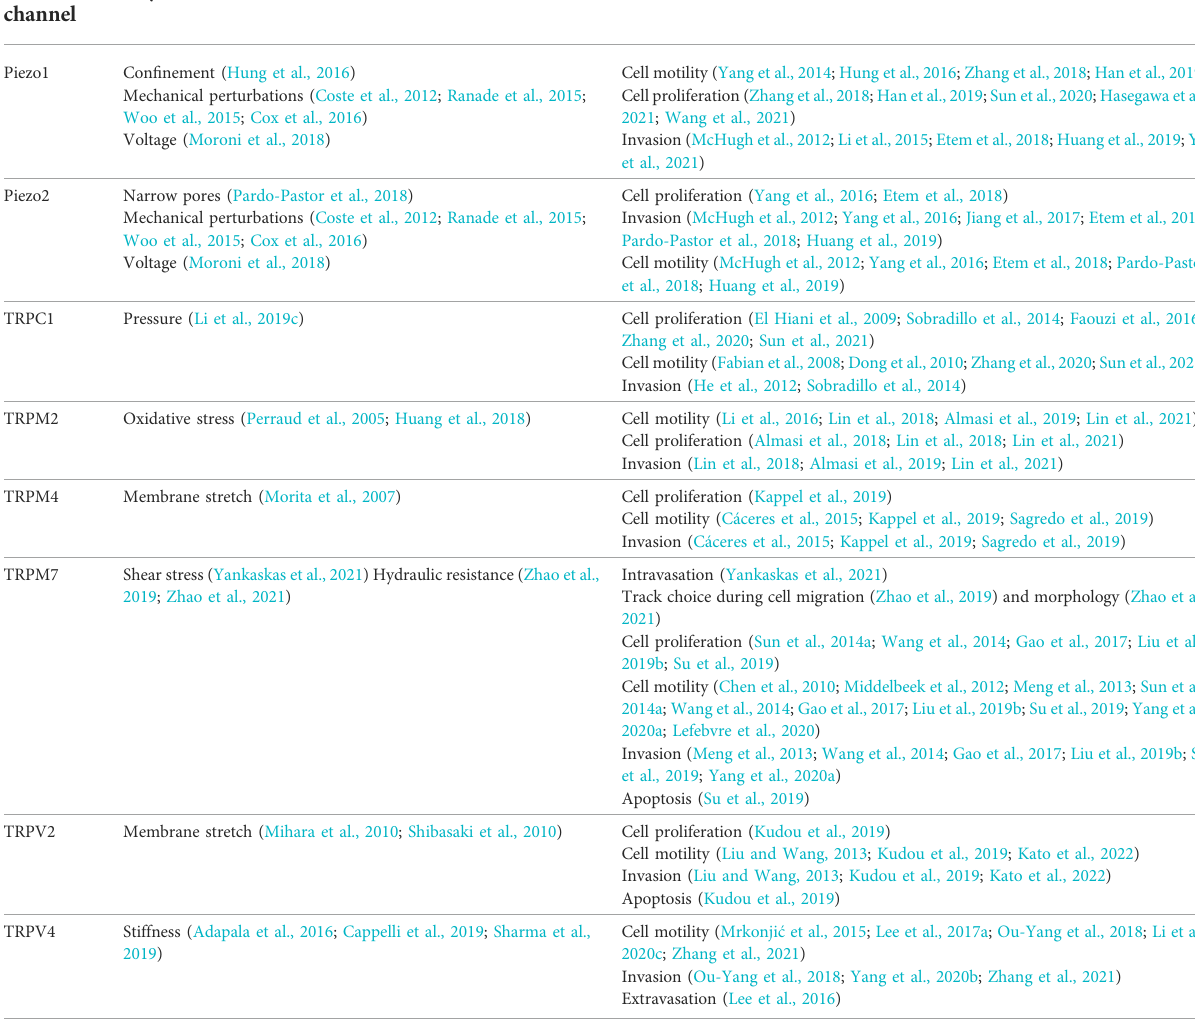
TABLE 3 Ion channels involved in tuning cell behavior in response to physical